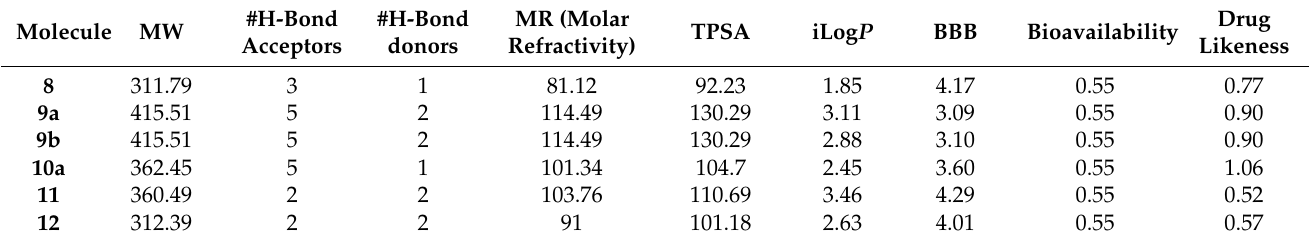
Table 5. Results of pharmacokinetics evaluation for the most promising kinase